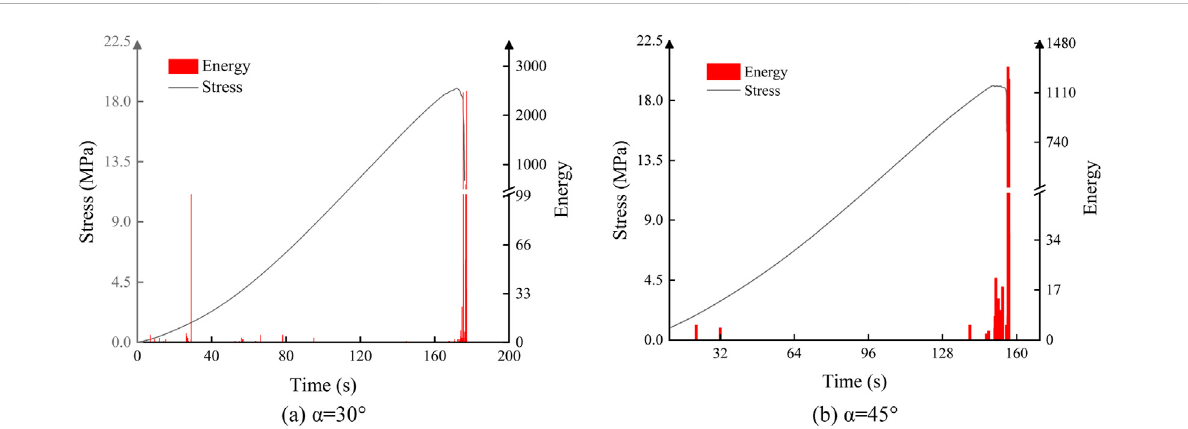
rock specimen with fracture angles were as follows.